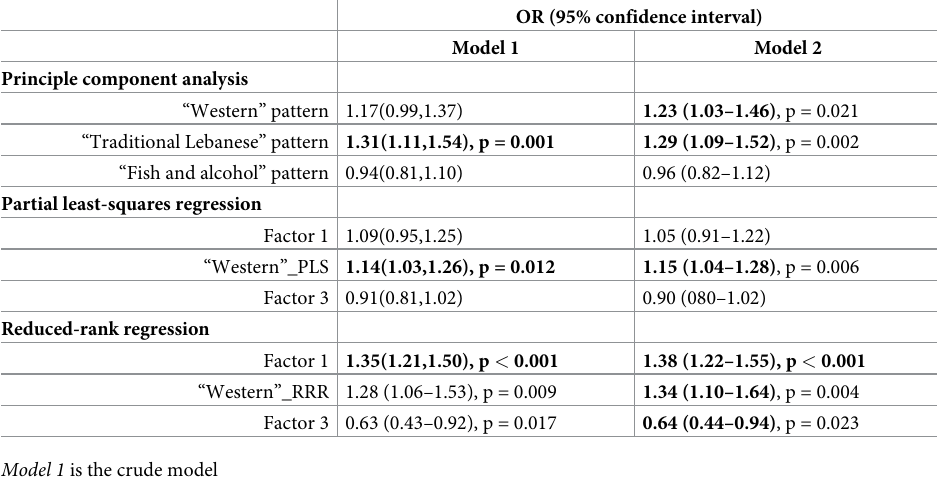
Table 4. Odds ratios and 95% confidence intervals for elevated BP and factor scores derived using principal com- ponent analysis, reduced-rank regression and partial least-squares (n =